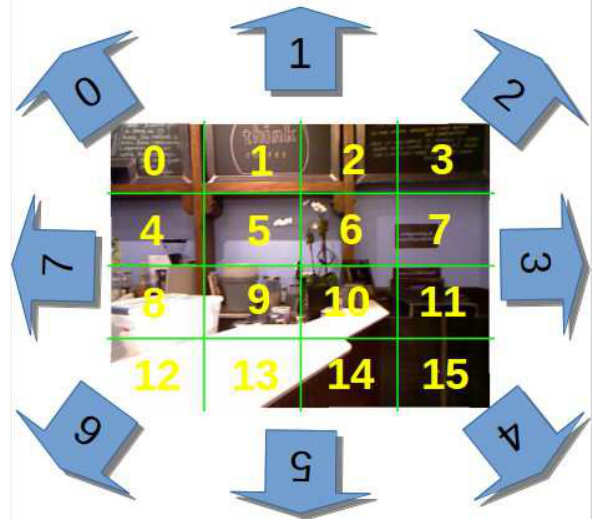
Figure 8. The direction of camera movement